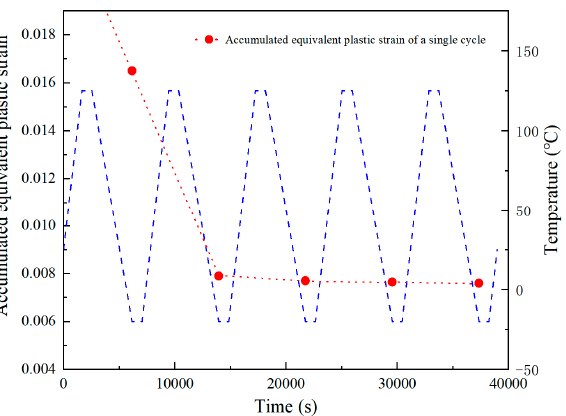
Figure 8. Accumulated equivalent plastic strain by a single cycle during temperature cycling of the “dangerous solder ball” in case 1.